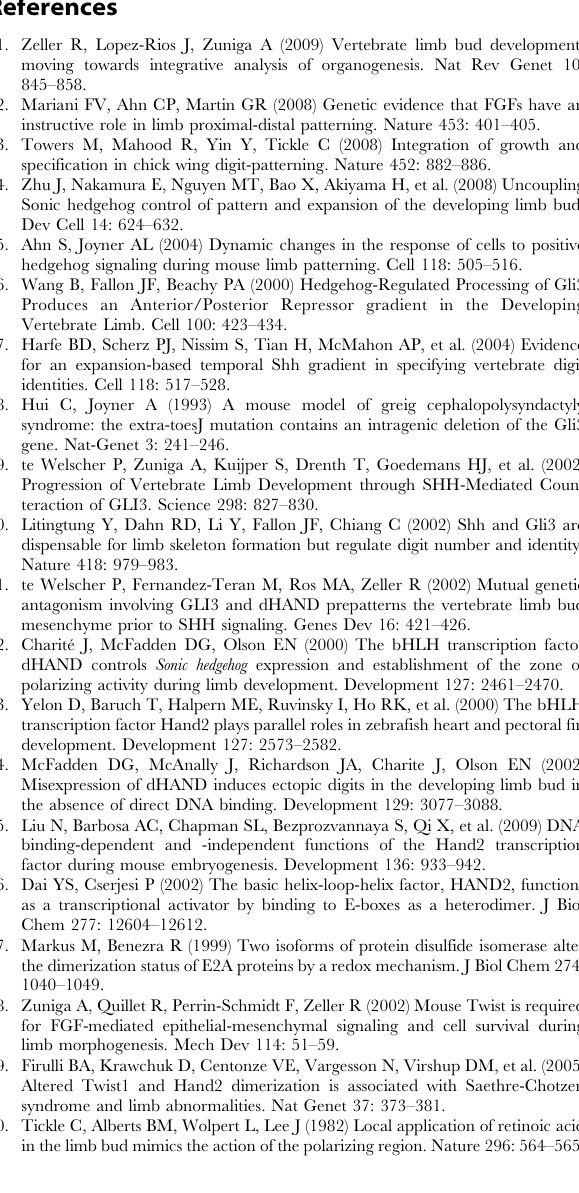
pre- and post-axial polydactyly in comparison to Gli3 Xt/Xt limb buds. White brackets indicate forelimb length. Asterisks indicate digits with undetermined identities. (B) The massive apoptosis of mesenchymal cells in Hand2 deficient limb buds is suppressed in limb buds lacking both Hand2 and Gli3 . Apoptotic cells were detected by TUNEL fluorescence on limb bud sections at E10.25 (33 somites). Sections are oriented with the anterior to the top and posterior to the bottom. Table S1 Oligos used for the study. All primers used for genotyping of mice and embryos, Q-PCR analysis of Hand2 transcripts, Q-PCR analysis of the ChIP experiments are listed. Conditions for use are available upon